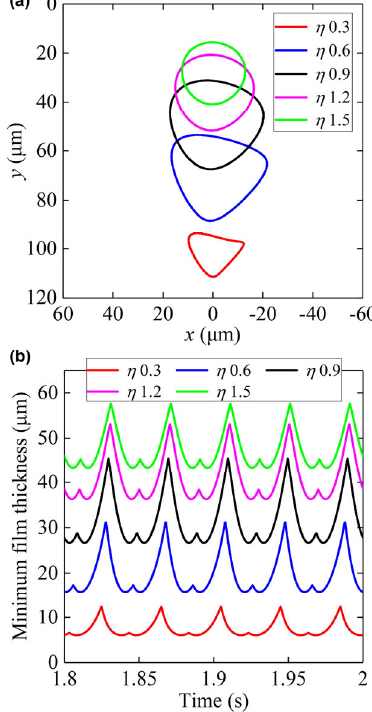
Fig. 9 (a) Journal center orbits and (b) dynamic minimum film thicknesses of a TPJB with static loads for different length-to- diameter